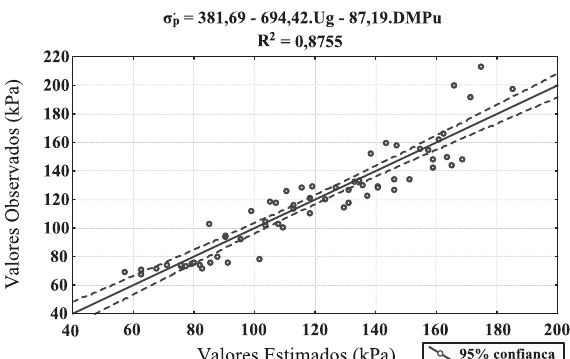
figura 7. modelo de tensão de pré-compactação ( s ´ p ) em função da umidade gravimétrica (ug) e do diâmetro médio ponderado dos agregados via úmida (dmpu). Valores estimados contra